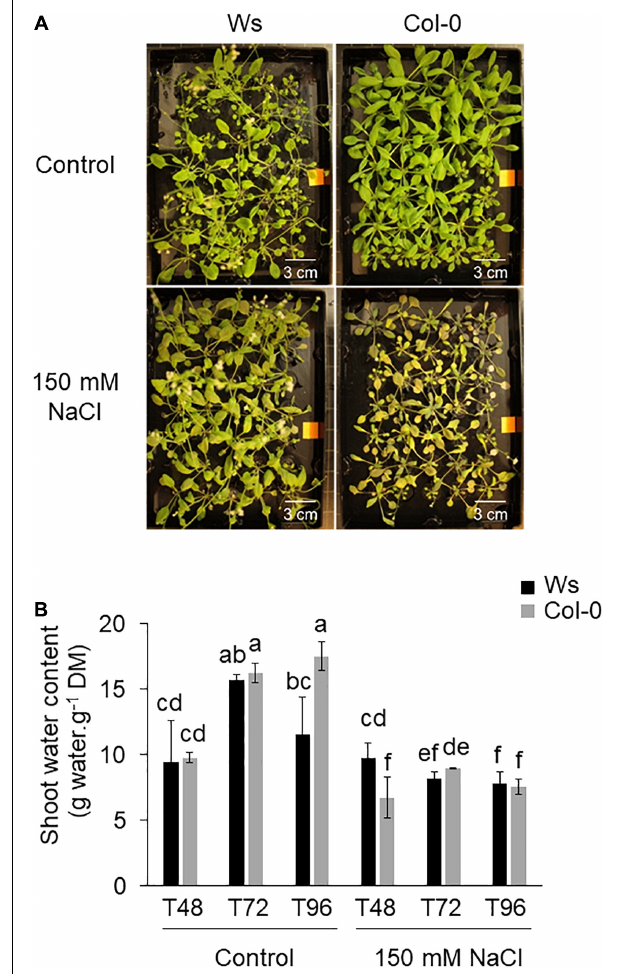
FIGURE 1 | (A) Shoot phenotype of Arabidopsis ecotypes Wassilewskija (Ws) and Columbia (Col-0) in response to salt stress. The 3-week-old plants grown hydroponically without (control) or in the presence of 150 mM of NaCl are shown at T96. (B) Effect of salt stress on the shoot tolerance index in Ws and Col-0 salt-treated plants. Data are means ± standard deviation of three biological replicates. Means followed by the same letter in the same graph are not significantly different according to Dunn